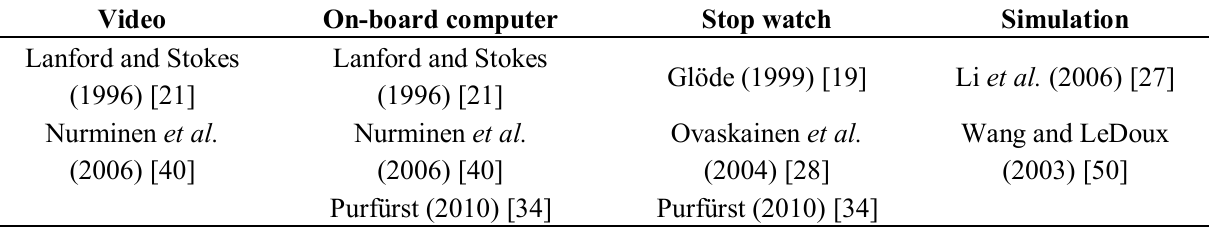
Table 7. Summary of data collection methods used in previous timber harvesting